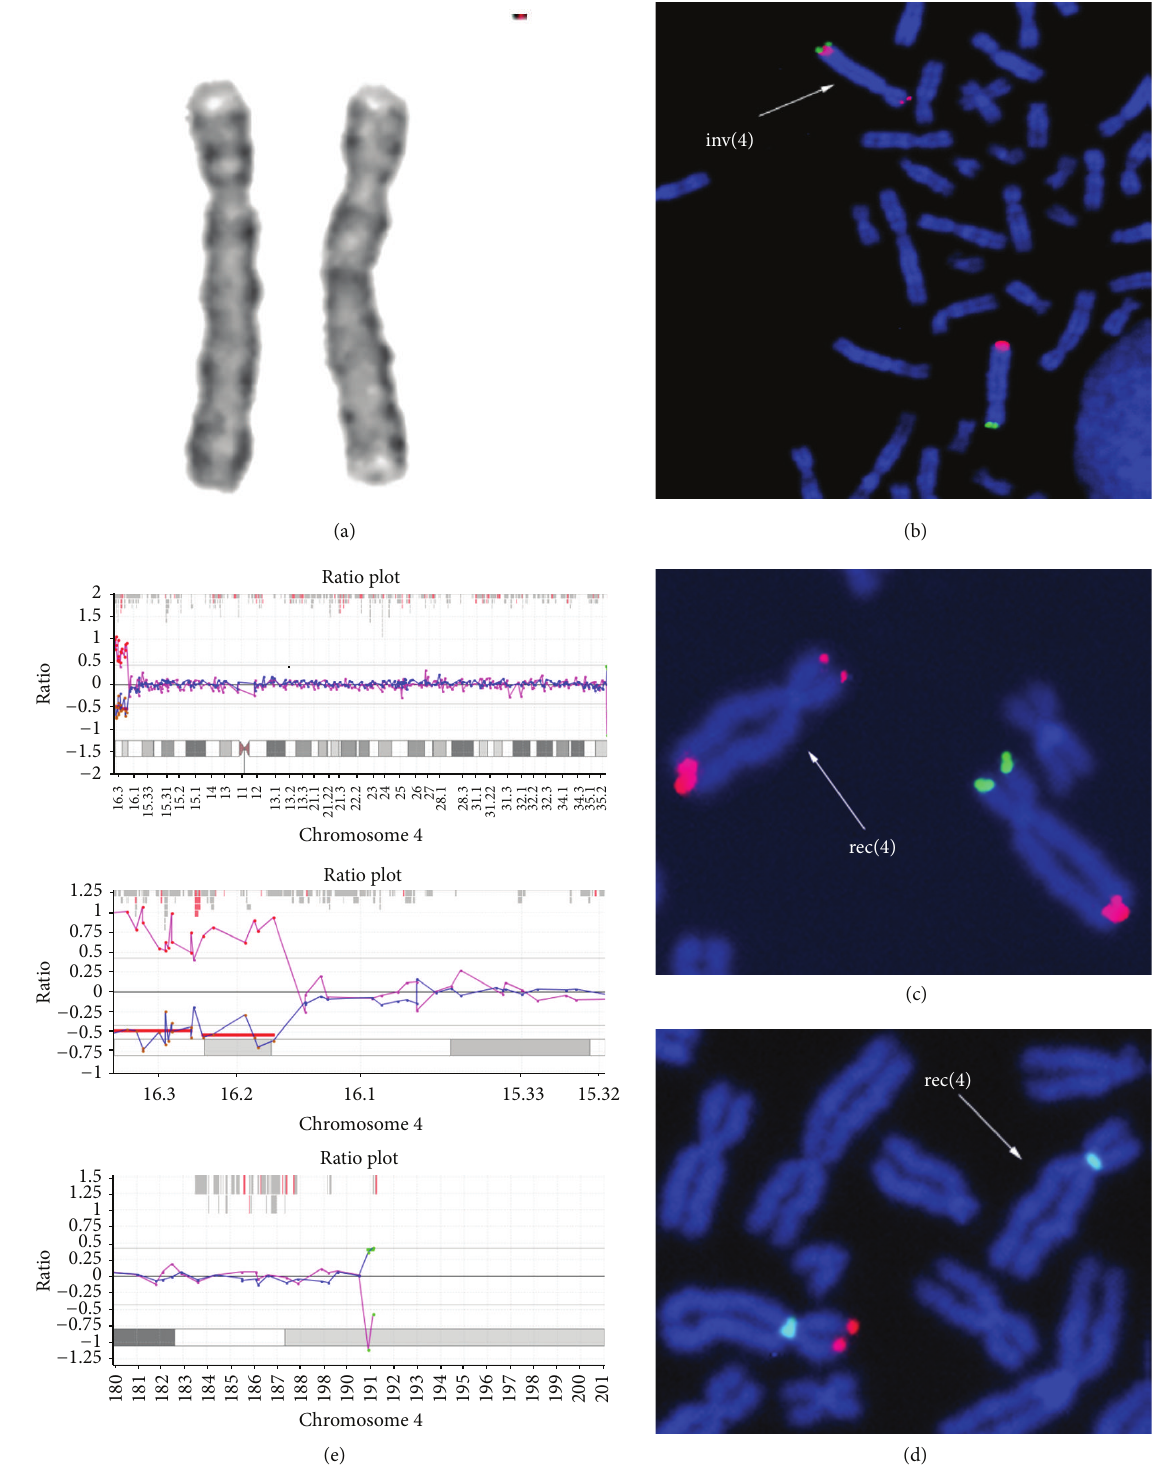
Figure 1: (a) GTG partial karyotype, only chromosomes 4 of heterozygote inversion carrier are shown (b) FISH on lymphocyte metaphases with tel4p and tel4q probes of heterozygote inversion carrier: tel4p probe signal (green) is located on the 4q subtelomeric region, while tel4q probe (red) shows a signal both on the subtelomeric 4q region and on the subtelomeric 4p region (low intensity) (c) FISH on amniocyte metaphase. The rec(4) (indicated by the arrow) shows the duplication of the tel4q probe signal (red) and the lack of the tel4p probe signal (green signal on normal chromosome). (d) WHS specific probe signal (red) is absent on rec(4), while CEP4 control probe signal (green) is shown on both chromosome 4 (e) Array-CGH of chromosome